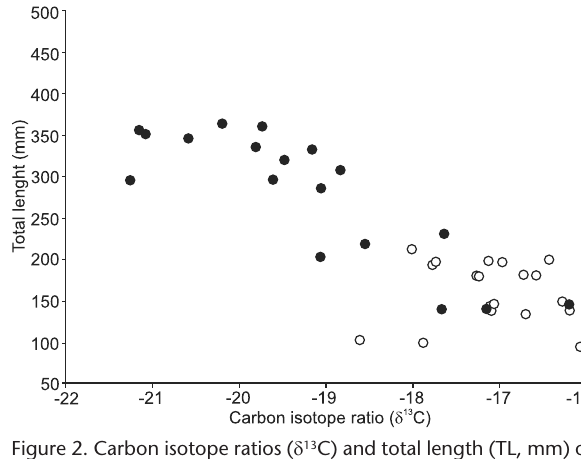
Figure 2. Carbon isotope ratios ( d 13 C) and total length (TL, mm) of individuals of Genidens genidens (closed circles) and Genidens barbus (open circles) collected in the interface between the estuarine and freshwater zones of Patos Lagoon in present